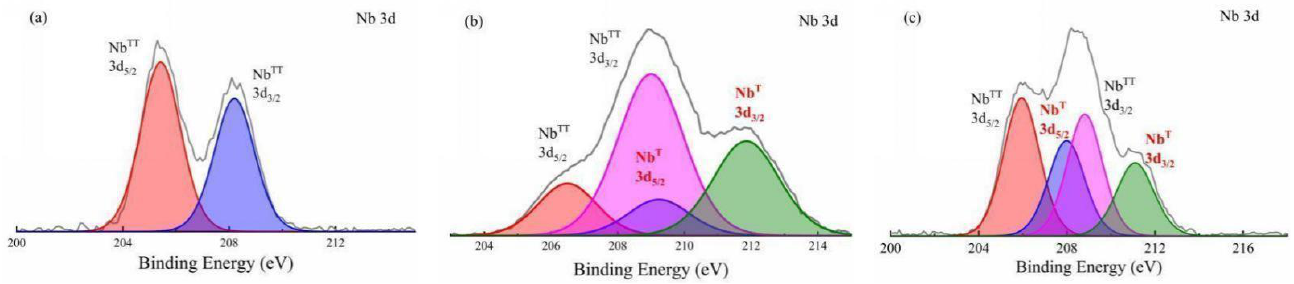
Figure 8. The Nb 3d XPS patterns of Nb/SiO 2 materials with n Nb = 1 calcined at various tempera- tures: ( a ) 400 °C, ( b ) 600 °C, and ( c ) 800 °C. ( a ) 400 ◦ C, ( b ) 600 ◦ C, and ( c ) 800 ◦ C.